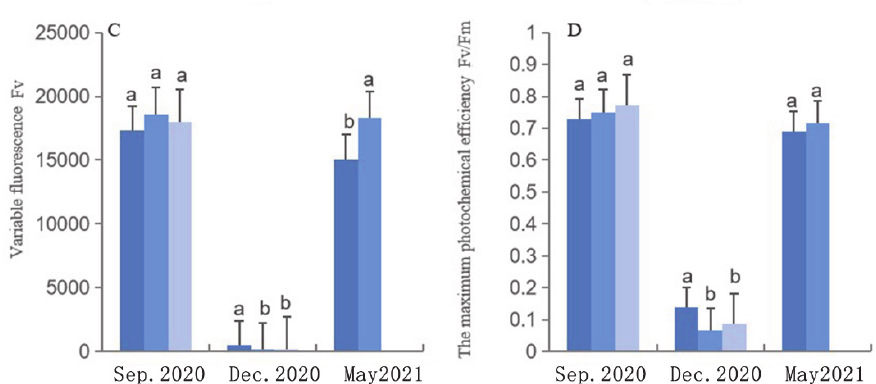
Figure 5. Changes in the chlorophyll fluorescence parameters in three Euonymus species. ( A ) initial fluorescence; ( B ) maximum fluorescence; ( C ) variable fluorescence; ( D ) the maximum photochemical efficiency; a and b represent significant differences.